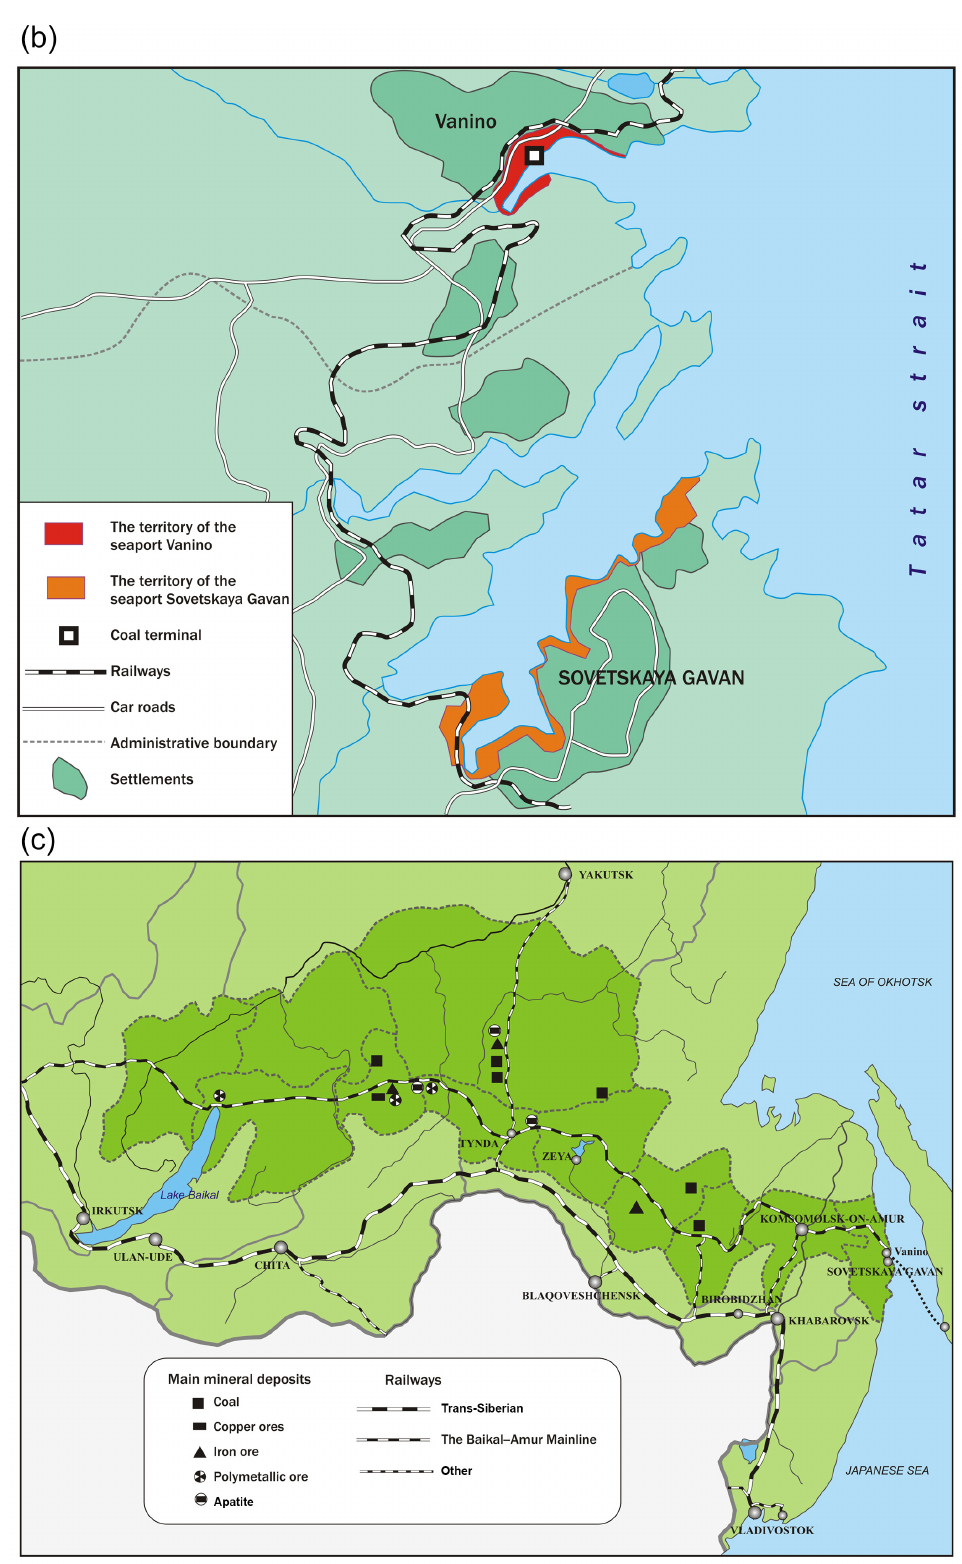
Figure 1. Geographical setting of the study: (a) seaports of the Russian Far East (distances are given in kilometers); (b) seaports of Vanino and Sovetskaya Gavan; (c) coal mining areas supplying the seaports of Vanino and Sovetskaya